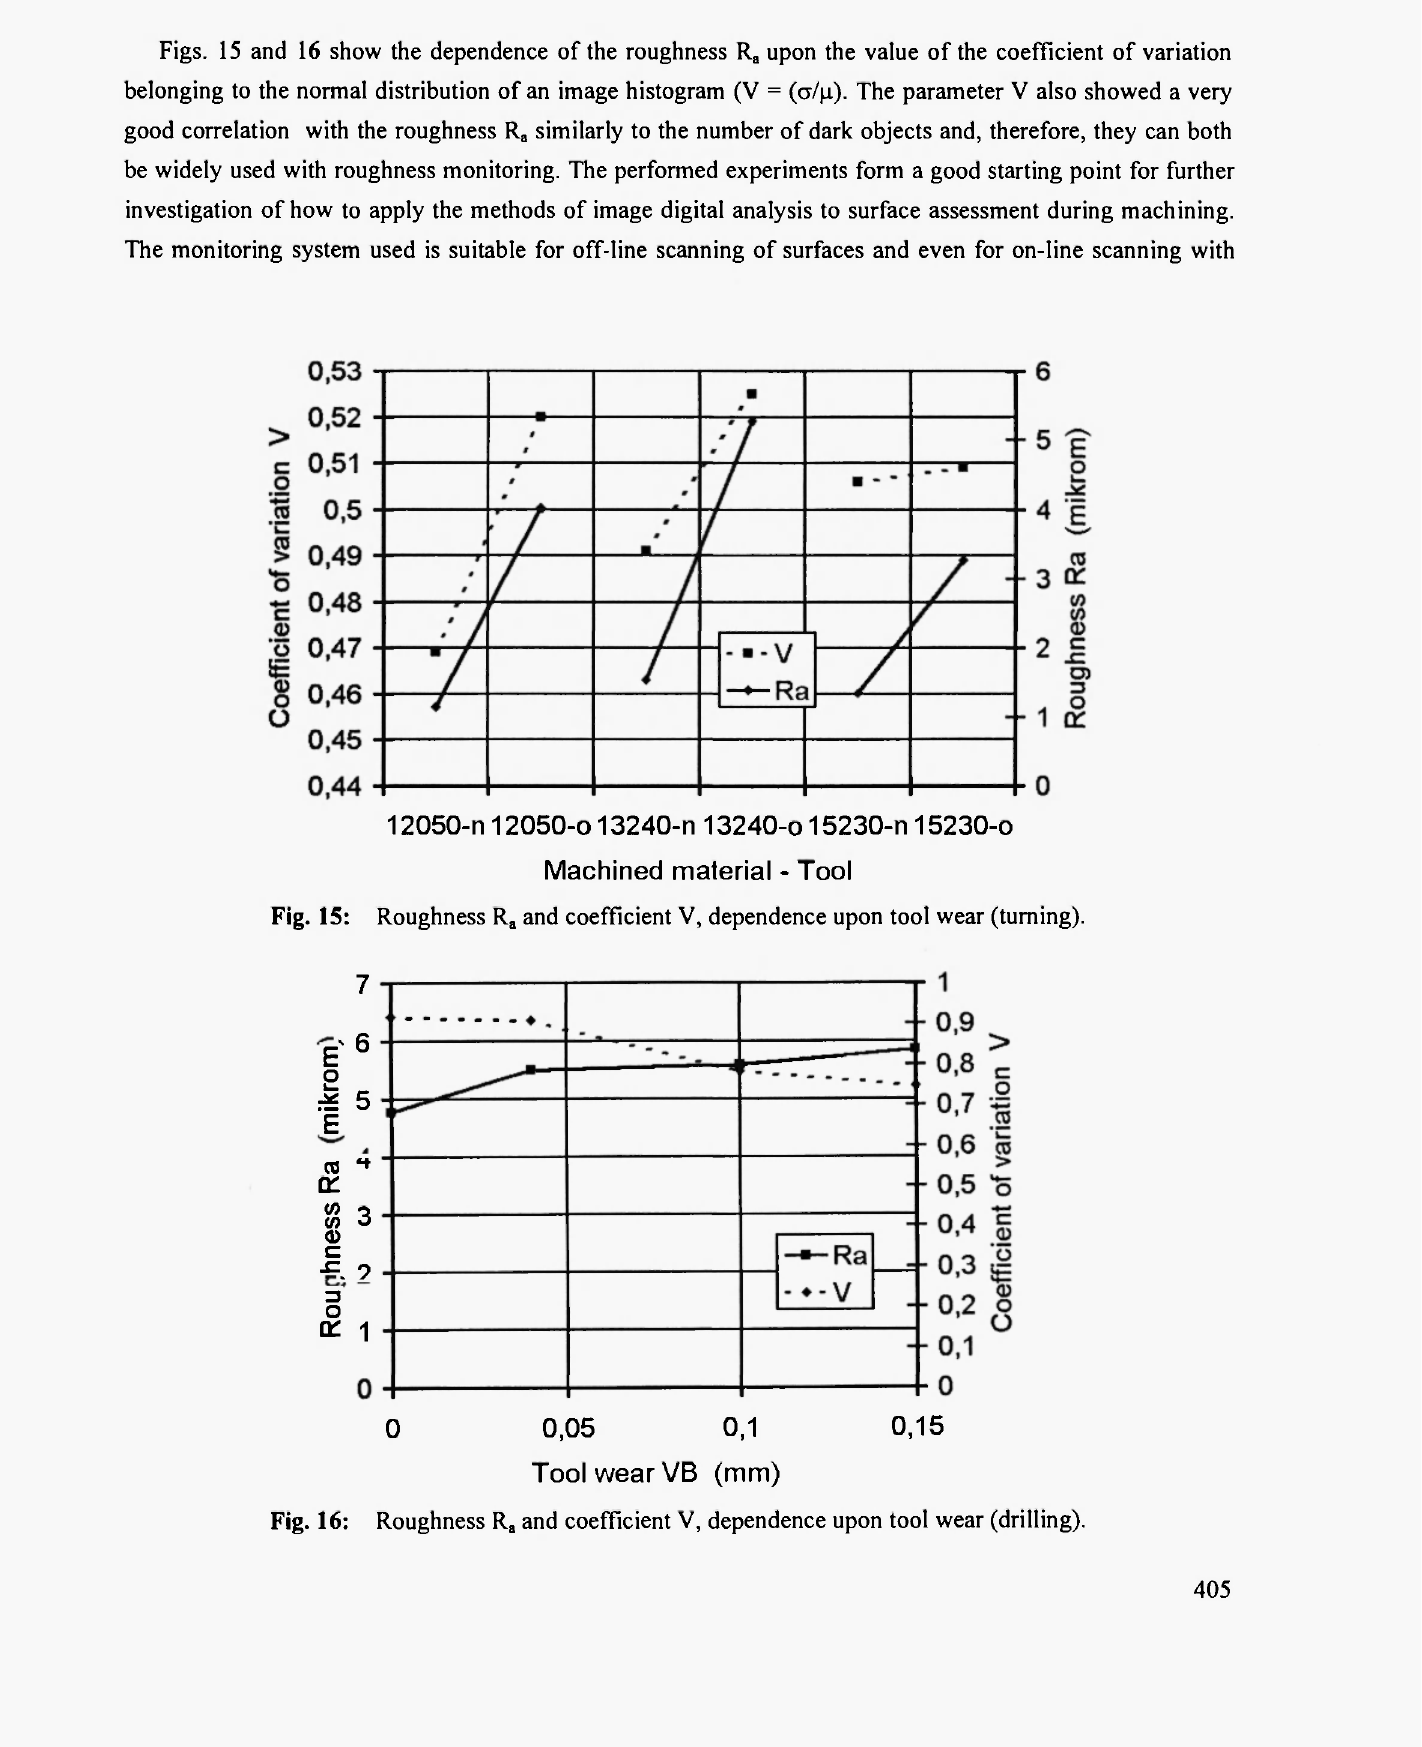
0 0,05 0,1 0,15 Tool wear VB (mm) Fig. 16: Roughness R a and coefficient V, dependence upon tool wear (drilling).